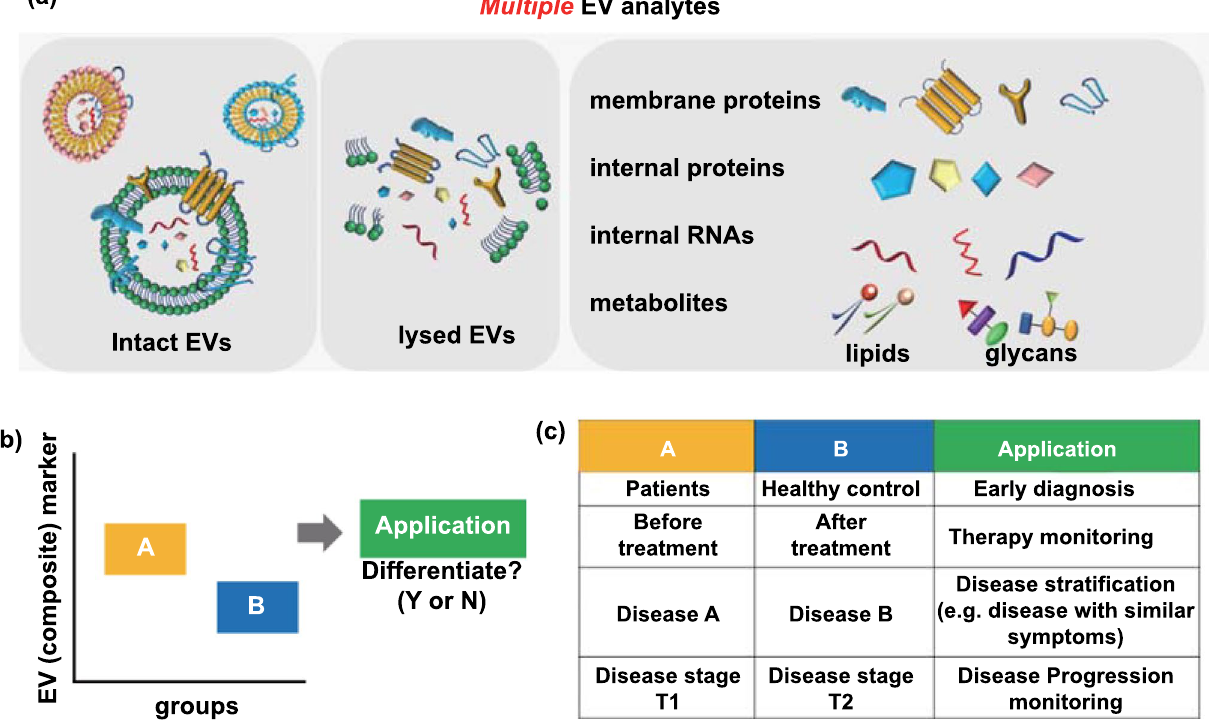
Fig. 1 Potential clinical applications of composite EV biomarkers. a The molecular profiling of EVs may be based on proteomics (e.g. mem- brane proteins and internal proteins), RNAs or metabolites (e.g. lipids and glycans). b The multiplexed analysis of EV components can generate a box plot representation of expression levels in A and B groups as defined in c . c Potential clinical applications of EV